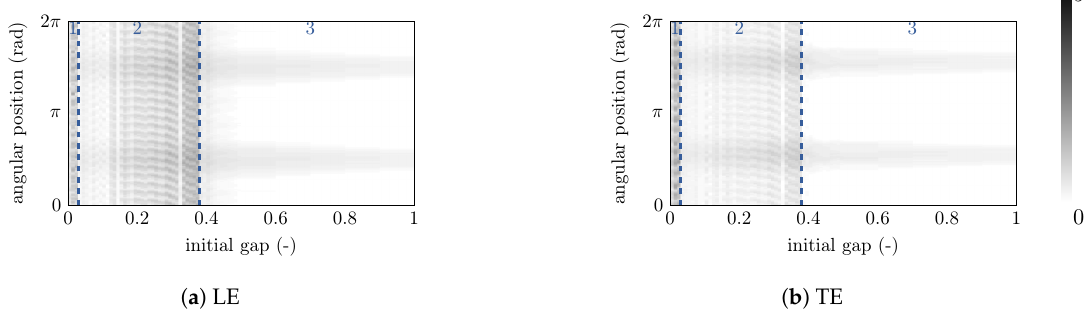
Figure 21. Evolution of the wear profile with the initial clearance for the HP compressor blade.